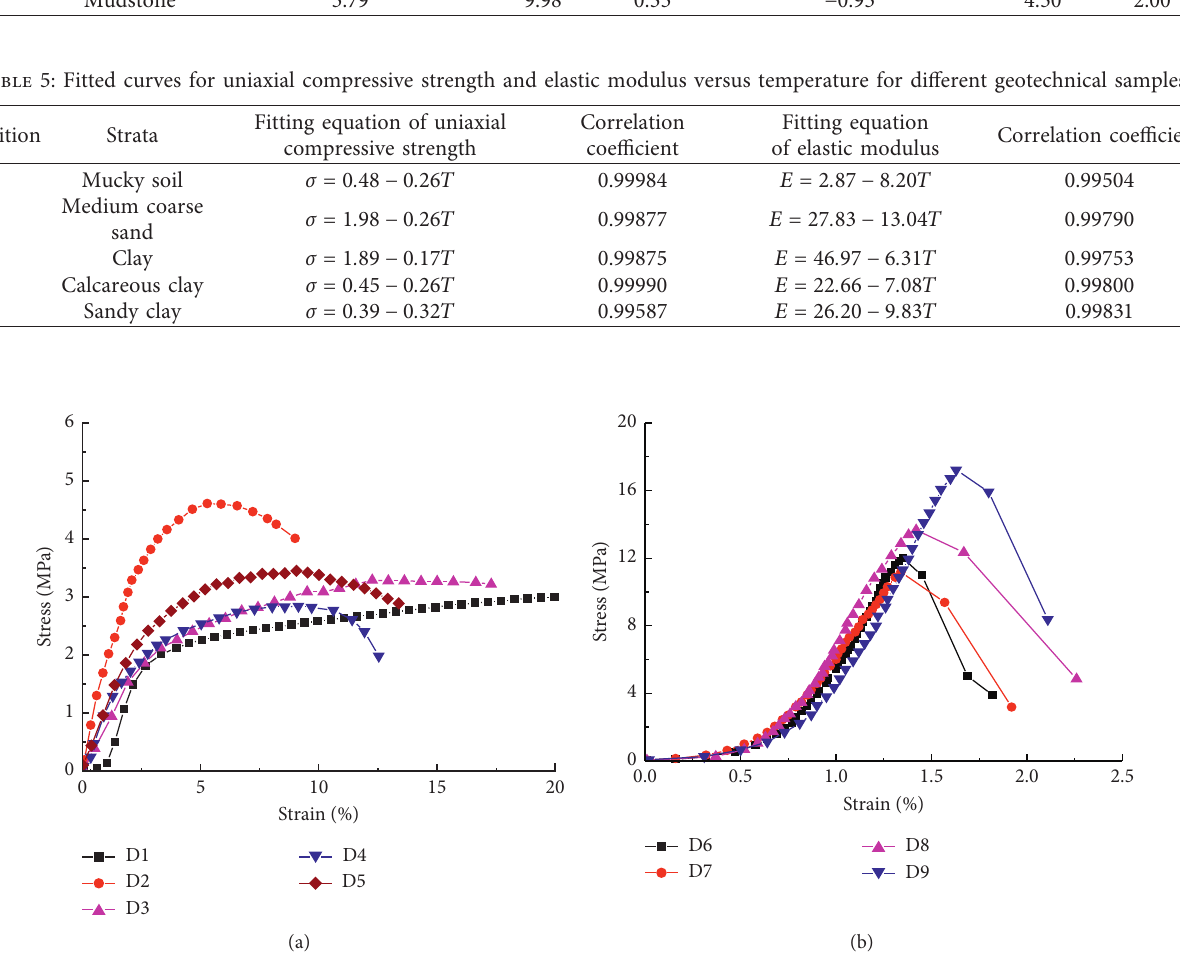
Figure 3: Stress-strain correlation curve of different rock and soil samples at − 10 ° C (second sample in each group). (a) Topsoil strata. (b) Rock